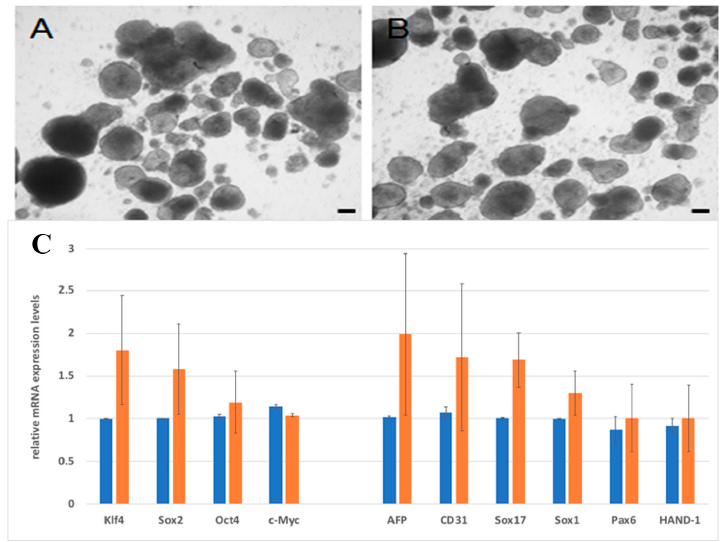
Figure 9. EB formation of H9 hESCs p60 after 14 days cultured in homemade E8 medium containing ( A ) hFGF-2 or ( B ) hDJ-1. Scale bar indicates 100 µm. ( C ) Gene expression profile of EBs differentiated from H9 hESCs p58 after 14 days cultured in homemade E8 medium containing hFGF-2 (blue bar) or hDJ-1 (orange bar). H9 hESCs cultured with hFGF-2 were injected into NOD mice, or hDJ-1 were injected into NOD or NOD/SCID mice to test in vivo pluripotency. After 12 weeks, teratomas were formed in three mice out of three NOD mice injected with hFGF-2 and three mice out of six NOD or NOD/SCID mice injected with hDJ-1. The teratomas were isolated and analyzed for three germ layers (Figure 10). Neuroepithelium, cartilage, and glandular epithelium structure were found in hFGF-2 teratomas. Squamous epithelium, cartilage, and glandular epithelium structure were found in hFGF-2 teratomas and hDJ-1, respectively.